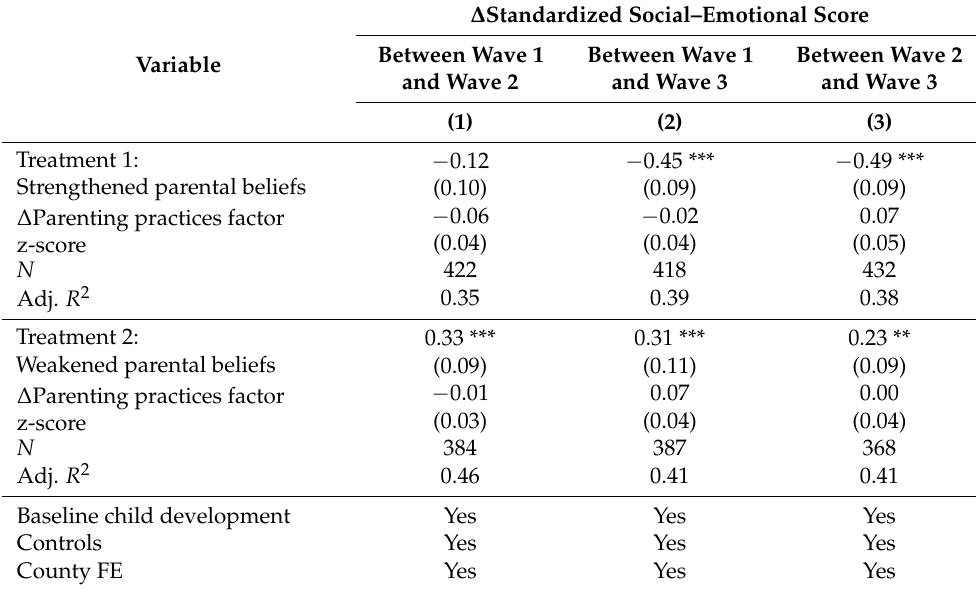
Table A2. Mediation analysis of child social–emotional development using DIDM